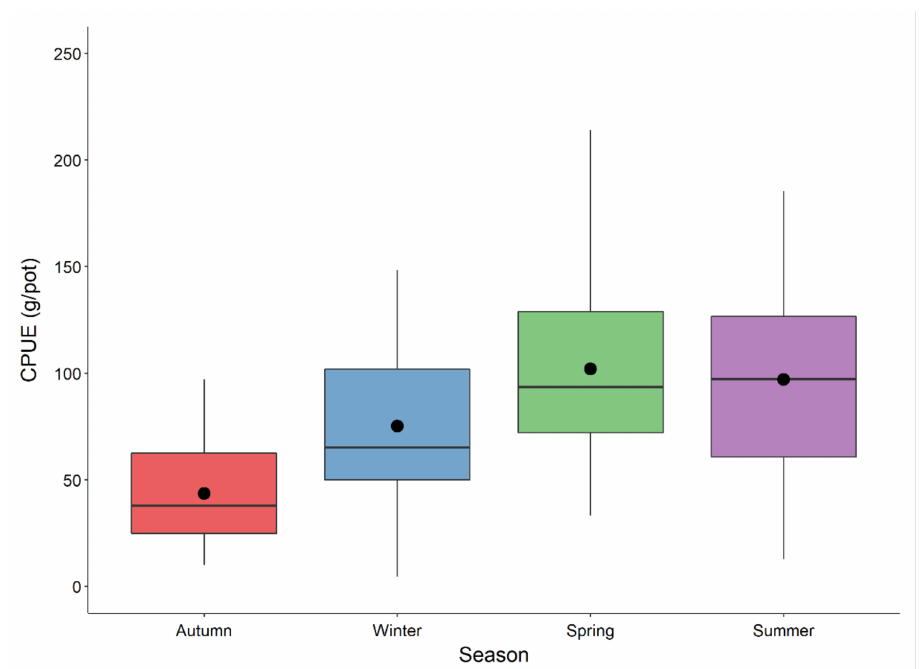
Figure 4. Seasonal variation of catch per unit effort CPUE (g/pot) of the European lobster ( Homarus gammarus ) in the Adriatic